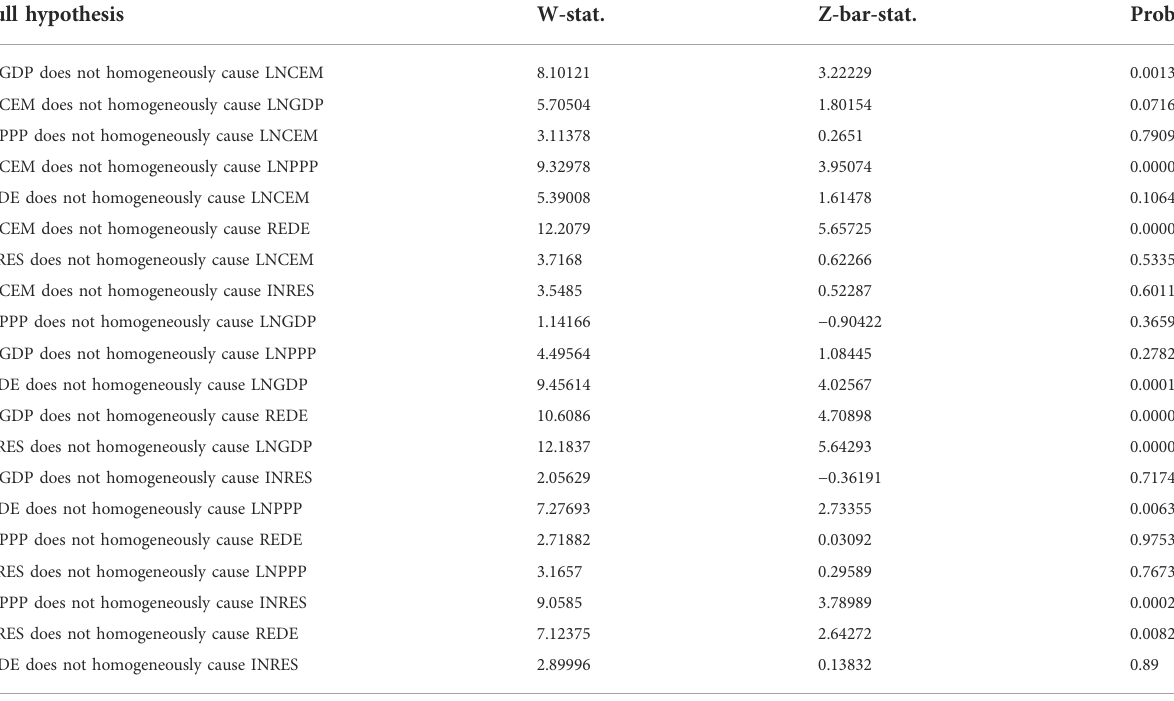
TABLE 3 Dumitrescu-Hurlin panel Granger causality test. Null hypothesis